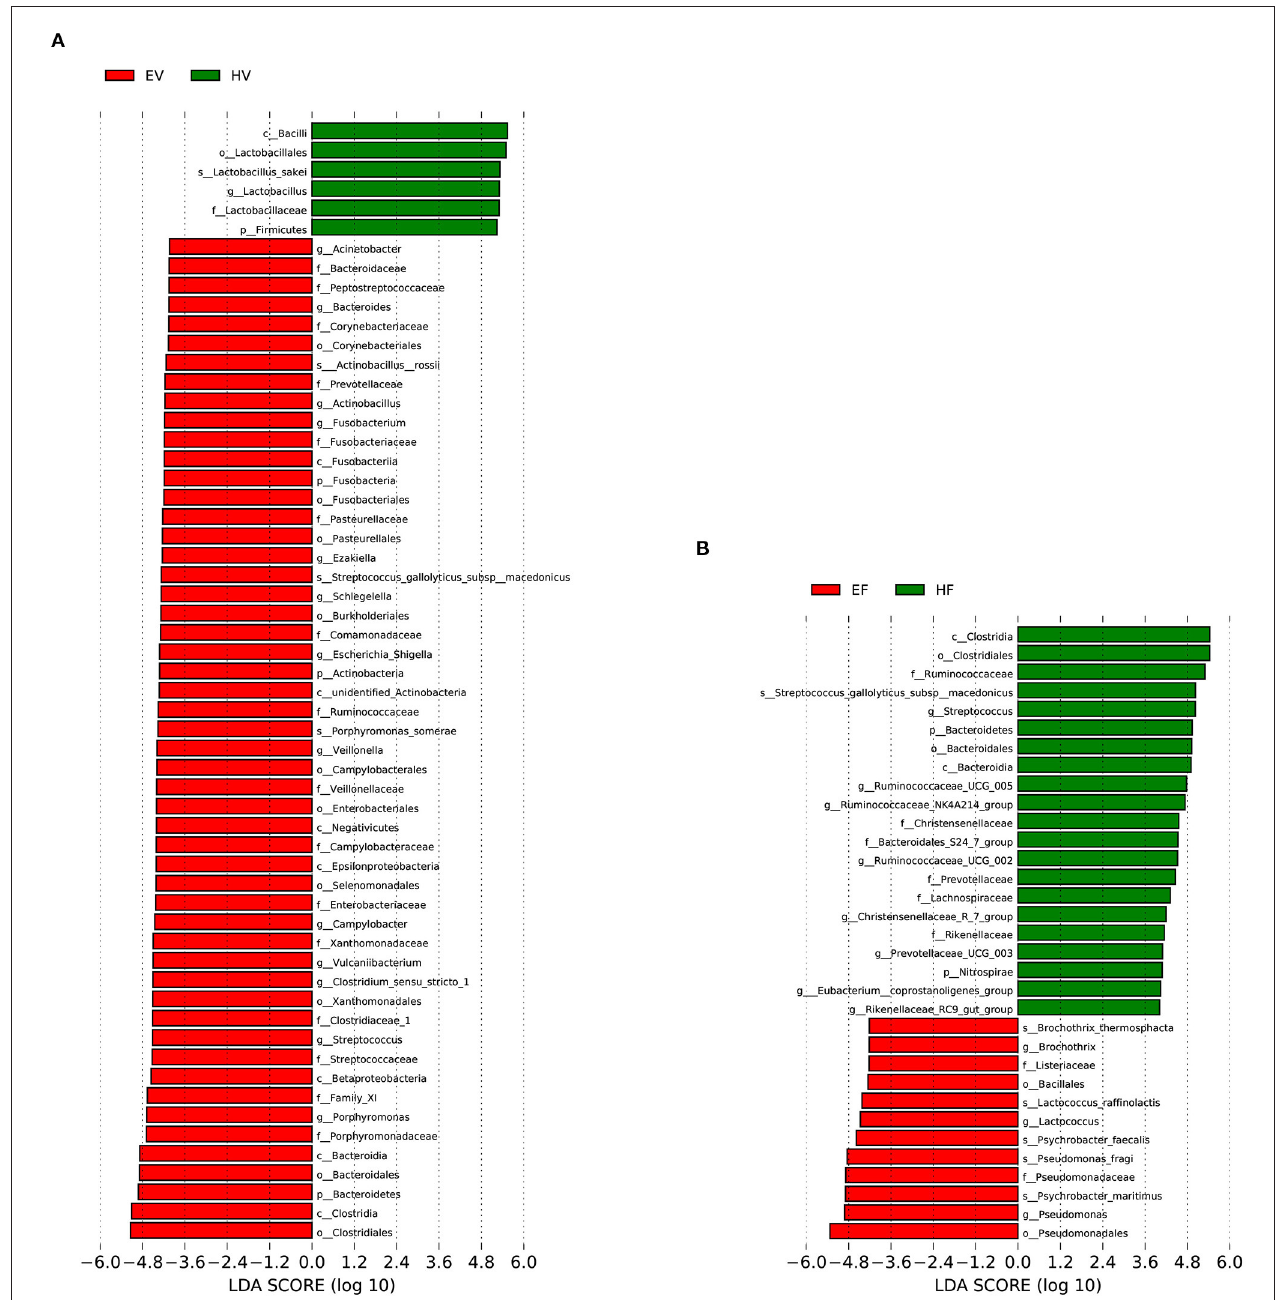
FIGURE 4 | Bacterial taxa significantly differentiated between sample groups identified by linear discriminant analysis coupled with effect size (LEfSe) using the default parameters. (A) Different taxa between EV and HV samples; (B) different taxa between HF and EF samples.